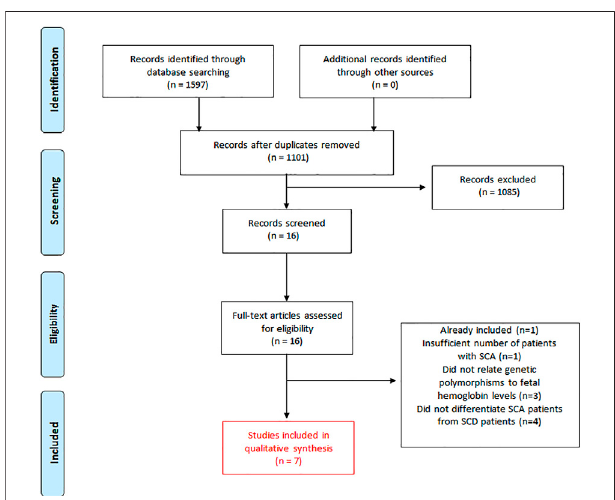
FIGURE1| Flowdiagramoftheliterature searchandthestudyselection for this systematic review of published articles related to the effect of genetic polymorphisms on HbF levels in patients with SCA (Hb SS) treated with